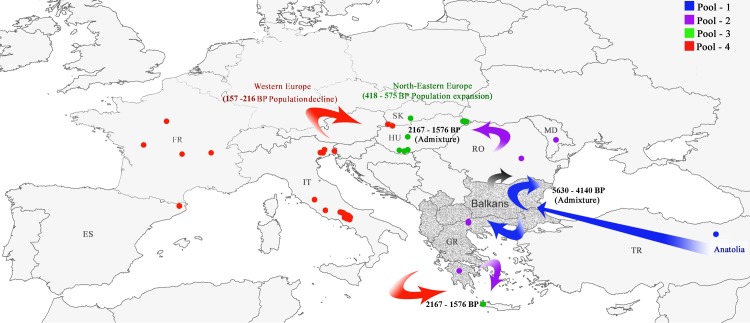
Human-mediated dispersal routes of walnut during the Late Holocene as inferred by DIYABC analysis.Human-mediated dispersal routes of walnut during the Late Holocene as inferred by approximate Bayesian computation [45]. Arrows represent the relationships between population pools used in DIYABC analysis (Pool 1, Pool 2, Pool 3, Pool 4) as inferred from stage 2, scenario 6b. Hypothetical glacial refugia located in the Balkans (ancestral pool NG1) are reported in dark grey. Abbreviations: TR = Turkey, MO = Moldova, RO = Romania, HU = Hungary, SK = Slovakia, GR = Greece, IT = Italy, FR = France, ES = Spain.